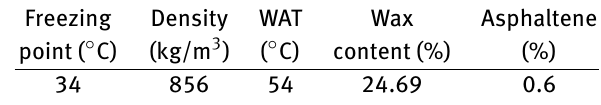
Figure 5: The comparison of description of rheological data between Model 1 and Model 2